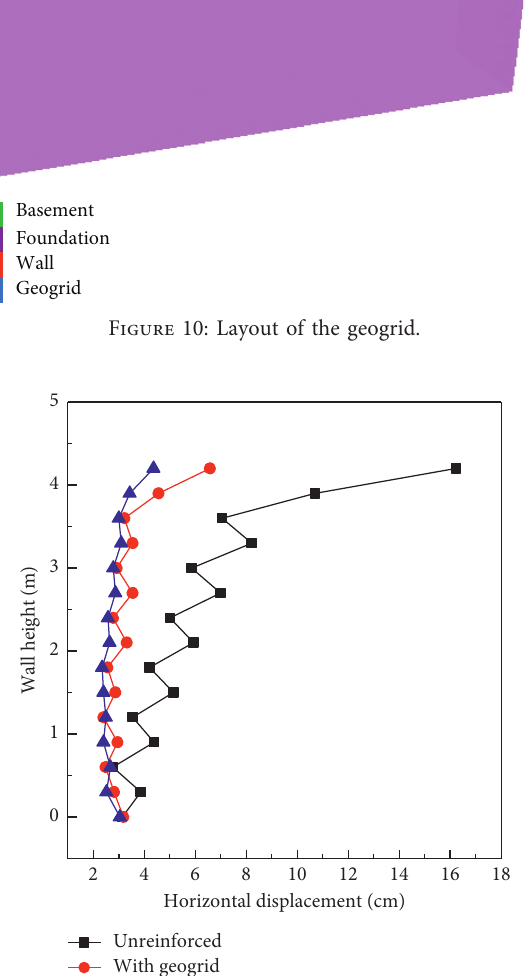
Figure 11: Horizontal displacement curve of three retaining wall